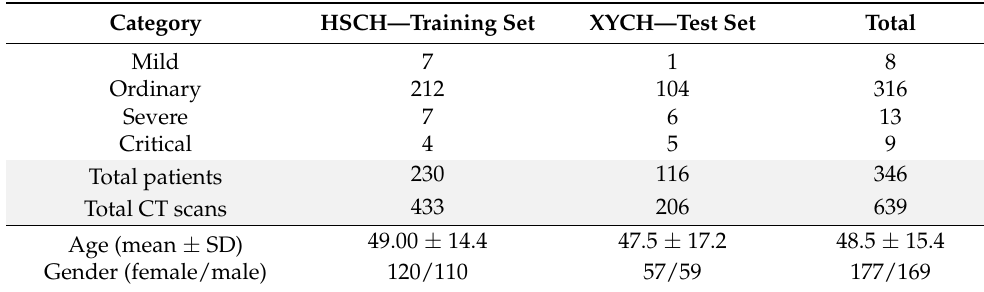
Table 1. Demographics of the patients in Task 1 dataset.